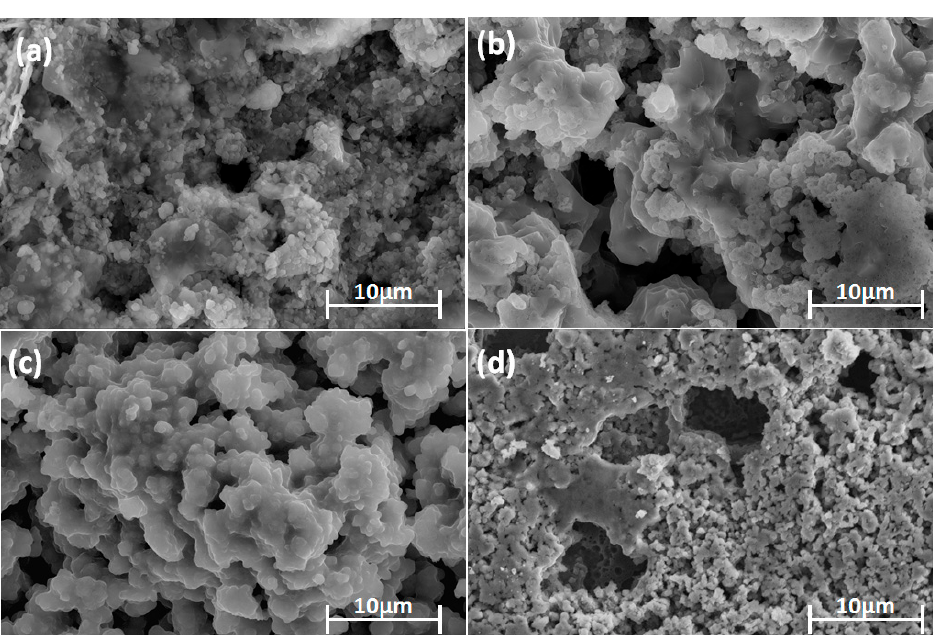
Figure 5. Optical micrographs of ( a ) HA, ( b ) TaHA, ( c ) SrHA (inset image is taken at higher mag- nification), and ( d ) SrTaHA.